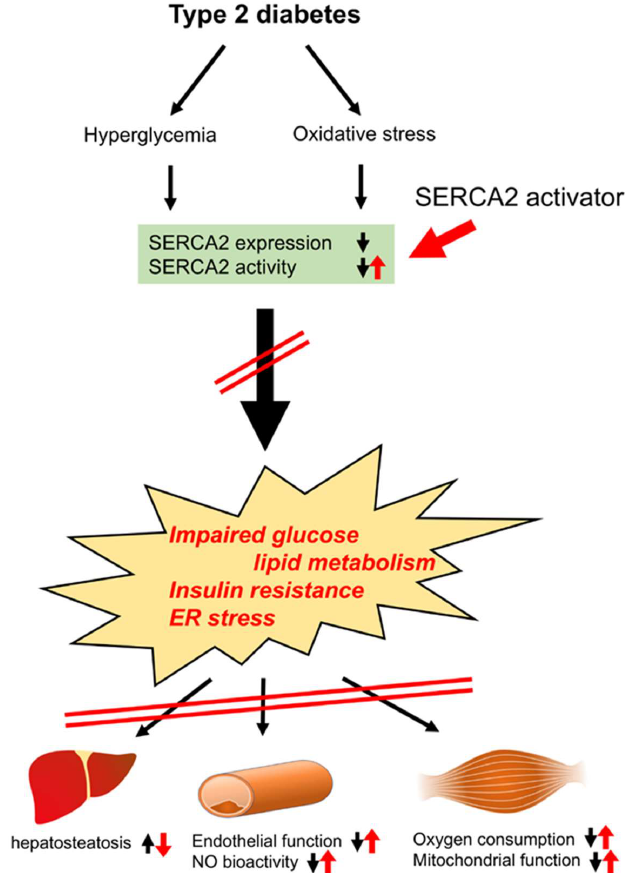
Figure 8. Mechanisms by which SERCA2 activator (CDN1163) improves the function of the liver, vascular tissue, and skeletal muscle. Hyperglycemia and oxidative stress induced in type 2 diabetes decrease SERCA2 expression and activity. CDN1163 ameliorates impaired glucose lipid metabolism, insulin resistance, and ER stress, then improves hepatosteatosis in the liver, endothelial dysfunction and NO bioactivity in vessels, and oxygen consumption and mitochondrial dysfunction in skeletal muscle. ER, endoplasmic reticulum; SERCA2, sarco/endoplasmic reticulum Ca 2+ -ATPase 2; NO, nitric oxide.